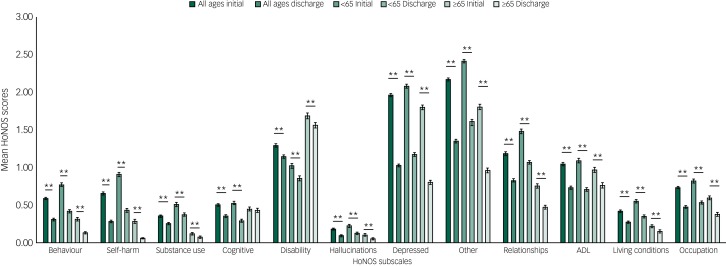
Non-psychosis disorder group: mean Health of the Nation Outcomes Scales (HoNOS) scores on initial assessment and discharge across the 12 HoNOS subscales.